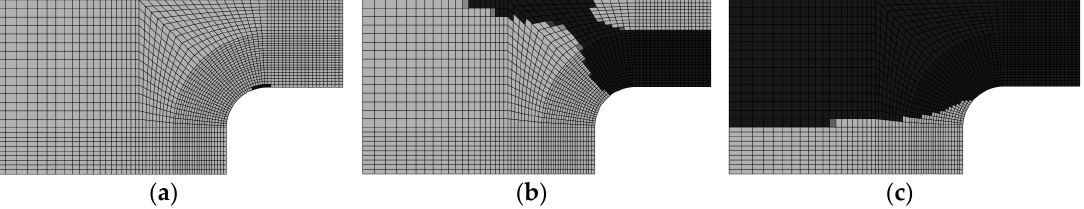
Figure 16. Matrix fragmentation damage of repaired fiber caused by transverse or shear compression (90°): ( a ) 50 kN; ( b ) 85 kN and ( c ) 213.1 kN.